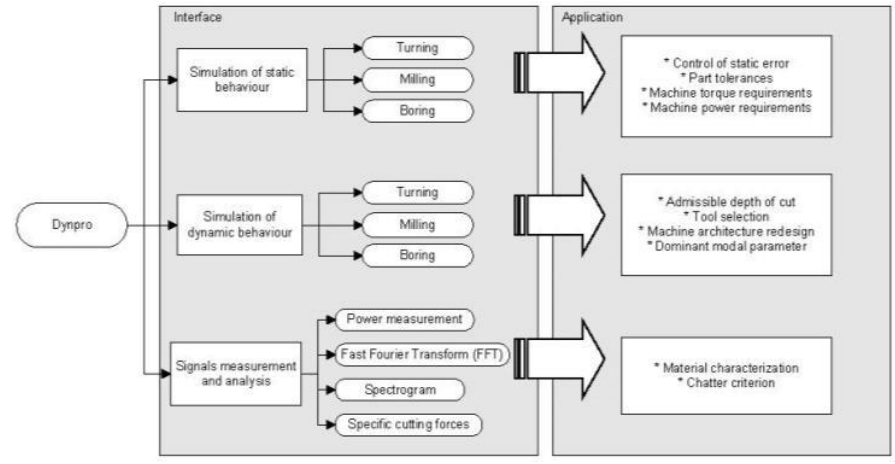
Figure 2. The functions and applications integrated in the approach.